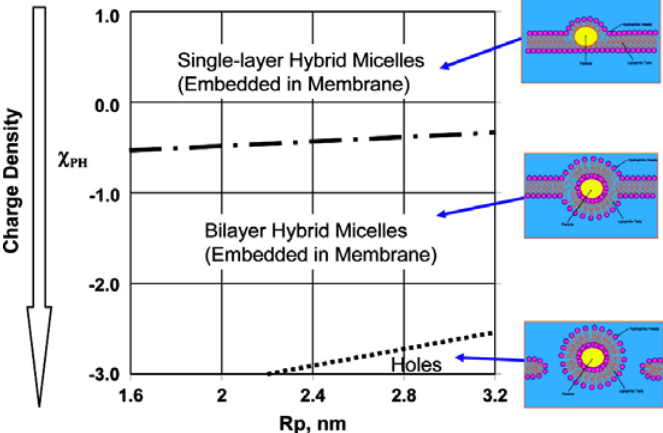
Figure 7 . Phase diagram for the morphology of membrane-nanoparticle complex as a function : two-dimensional particle radius) and surface charge ( χ of particle size (R P interaction parameter between the particle and the headgroup). Reprinted with permission from [33]. Copyright 2007 American Chemical